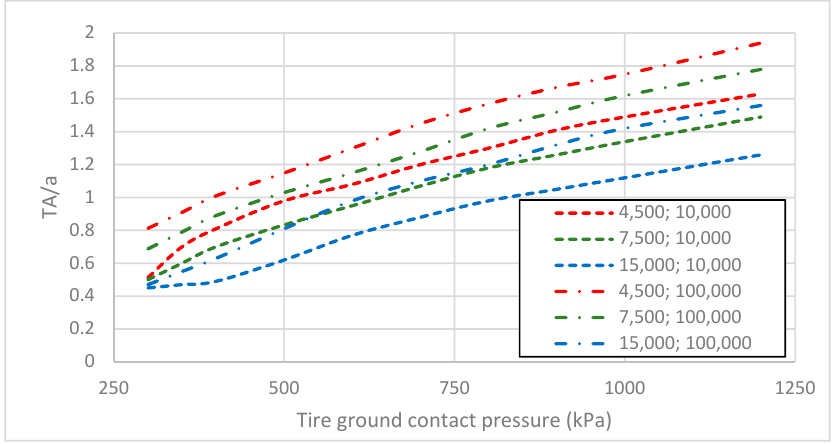
Figure 2. Design T A / a values for the allowable single wheel loads (ASWL) curves. In the legend the first number refers to the SM value in psi; the second number refers to the overall number of passes.